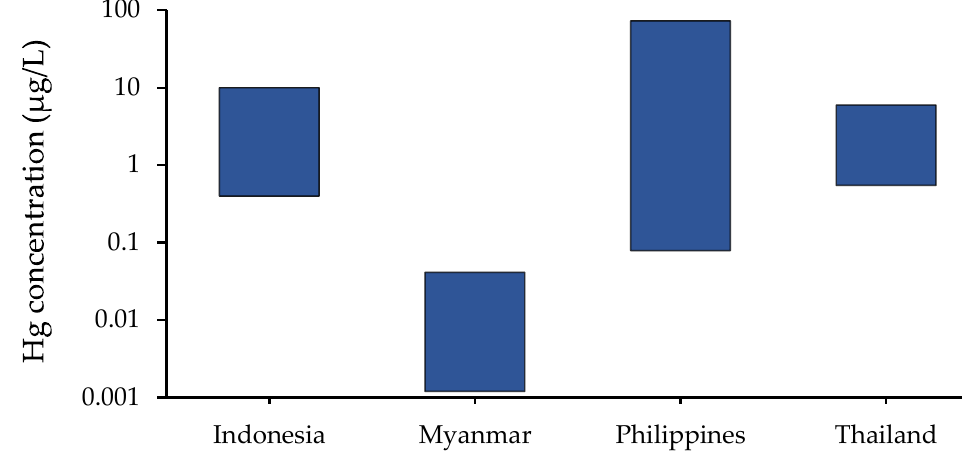
Figure 6. Hg concentrations in waterbodies from Indonesia [33], Myanmar [21], the Philippines [37], and Thailand [31]. Each piece of data represents a Hg concentration of range value, which was from a single study.